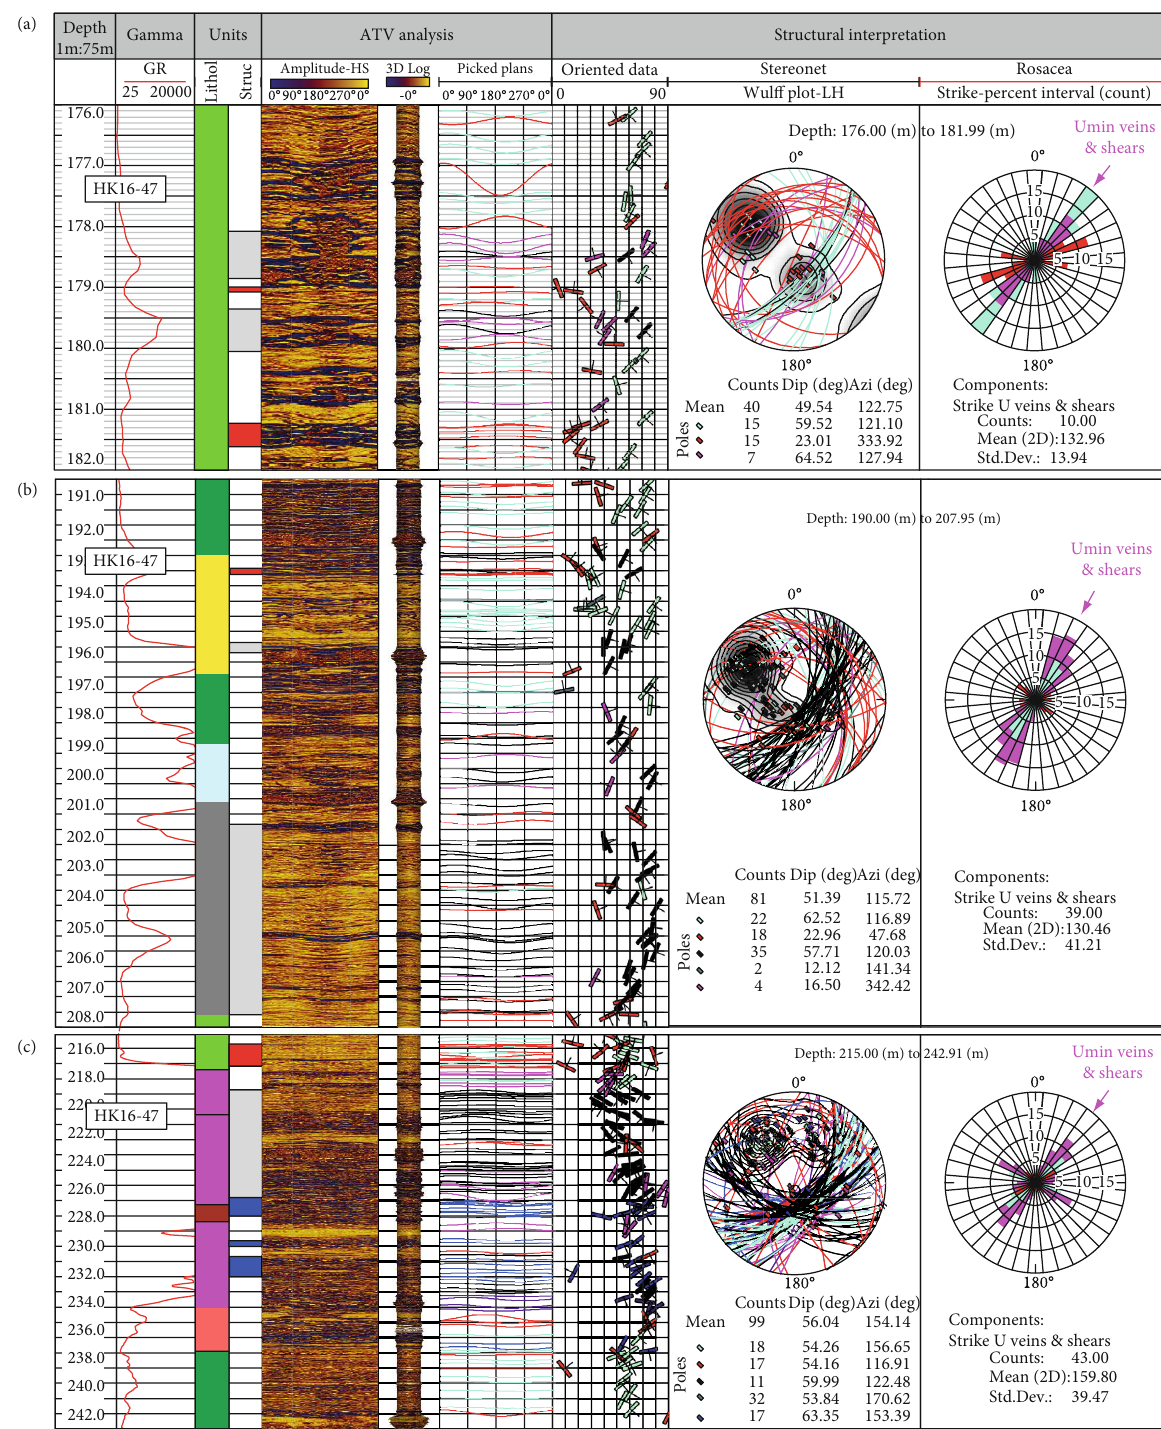
Figure 16: ATV data structural analysis from drill hole HK16-47. Zoom in on oriented data of (a) the upper mineralized zone 1, (b) the intermediate mineralized zone, and (c) the lower mineralized zone. Mineralized shears are in this fi gure in black. Umin: uranium mineralization. Legend in Figure